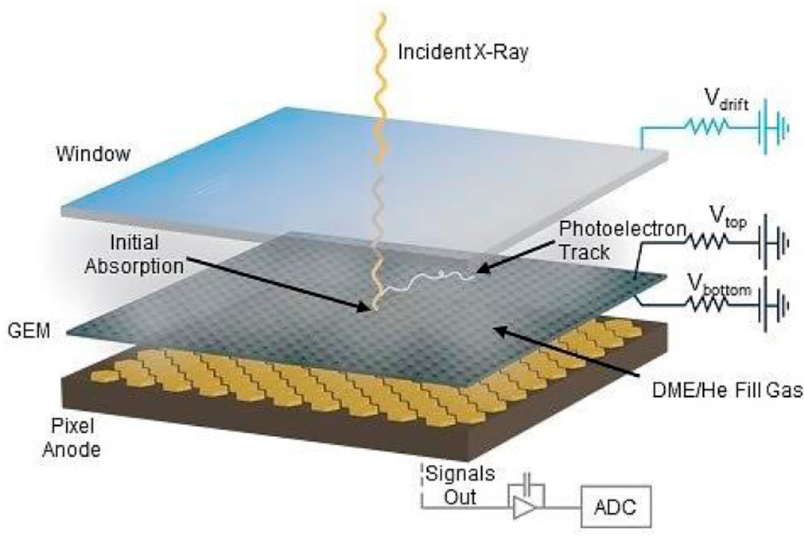
Figure 13. Schematic of the IXPE detector. Abbreviations: GEM = gas electron multiplier; ADC = analog to digital convertor; DME = dimethyl ether.